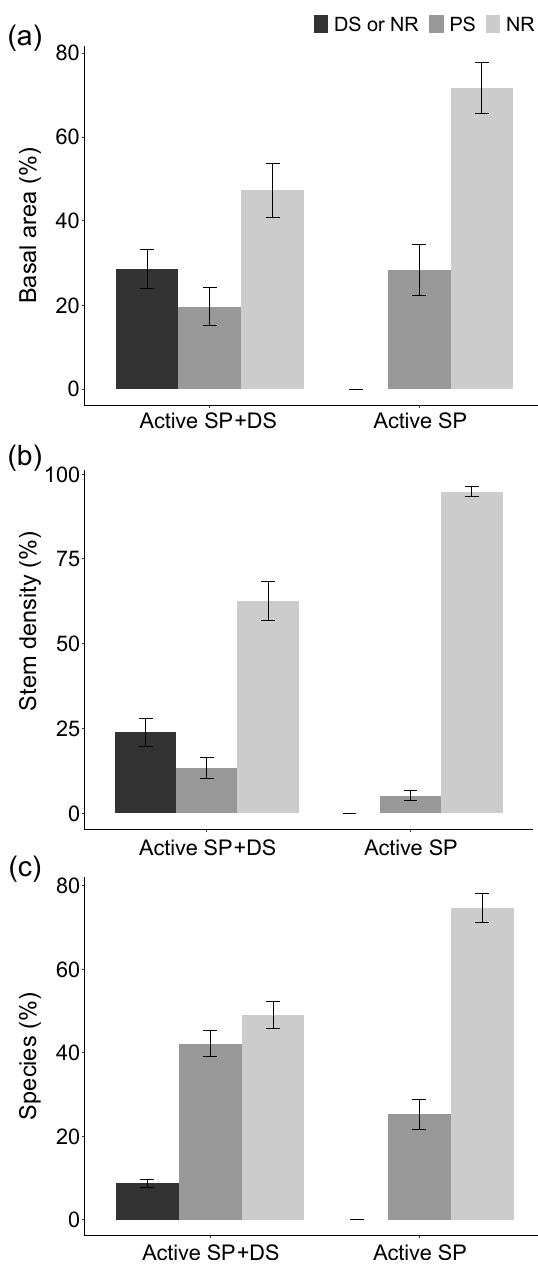
Figure 5. Contribution (mean percentage ± standard error) of planted seedlings (PS), direct seeding or natural regeneration (DS or NR), and natural regeneration (NR) to the ( a ) basal area, ( b ) stem density, and ( c ) species richness of active restoration sites. For 0.5–3.5-y-old sites, active restoration included seedling planting and direct seeding of pioneer species (AR SP+DS) and for 4.5–7.5-y-old sites, it included only seedling plantings (Active SP). A total of 36 active restoration sites were sampled in the south of Jirau Hydroelectric Reservoir along the upper Madeira River.